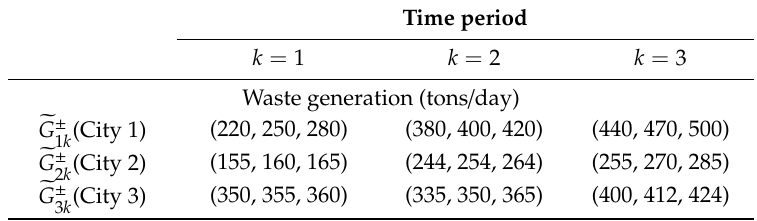
Table 2. Waste generation of